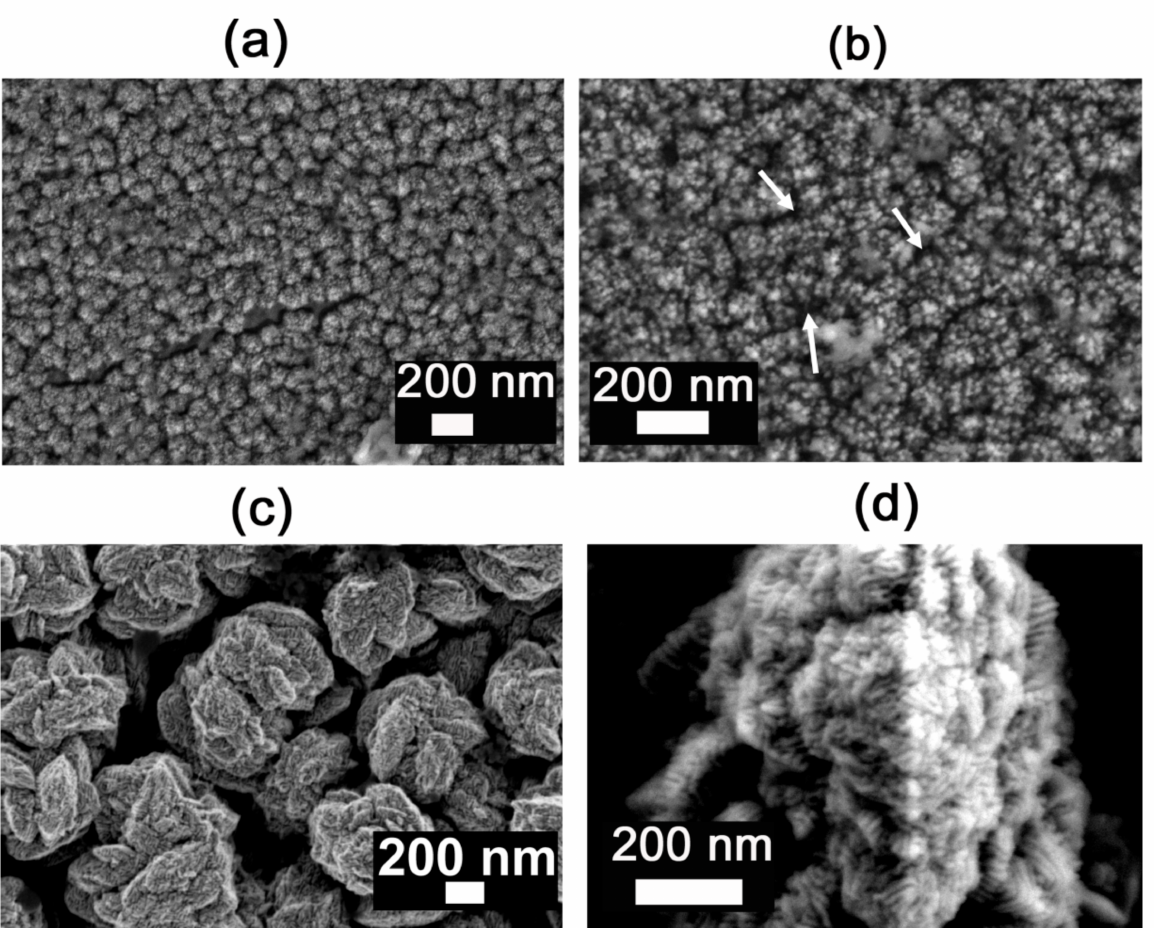
Figure 2. Low- and high-magnification SEM images of surface-mesostructured films with composition ( a , b ) Cu 20 Ni 80 and ( c , d ) Cu 45 Ni 55